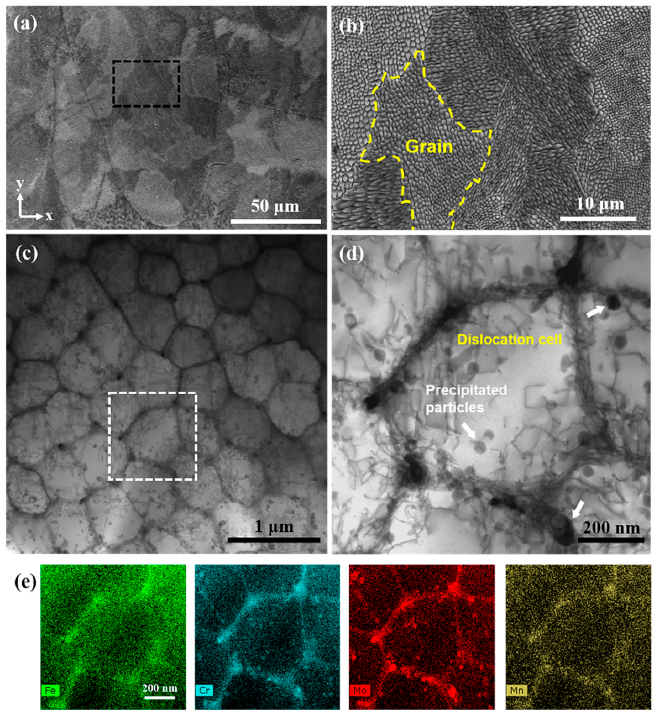
Figure 2. Microstructures of the as-fabricated GH3536 superalloy. ( a , b ) SEM images show the typical microstructure perpendicular to the building direction of L-PBF. ( c ) Bright-field STEM image shows the structure of dislocation cells with some precipitates. ( d ) Zoomed-in area marked by the white rectangle in ( c ). ( e ) Element-distribution maps of the selected area in ( c ), demonstrating the element segregation at the walls of dislocation cells.